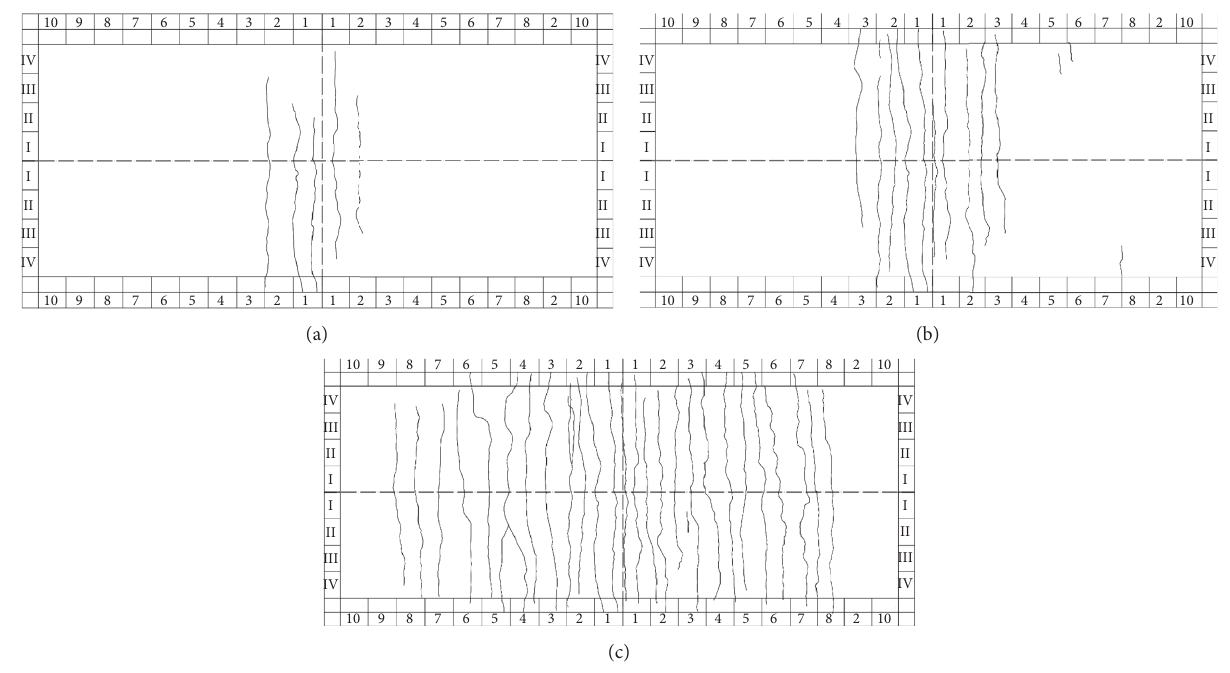
Figure 18: Distribution of cracks in the concrete slab of PLG-2. (a) 200kN. (b) After 200,000 cycles. (c) After 1.5 million cycles.